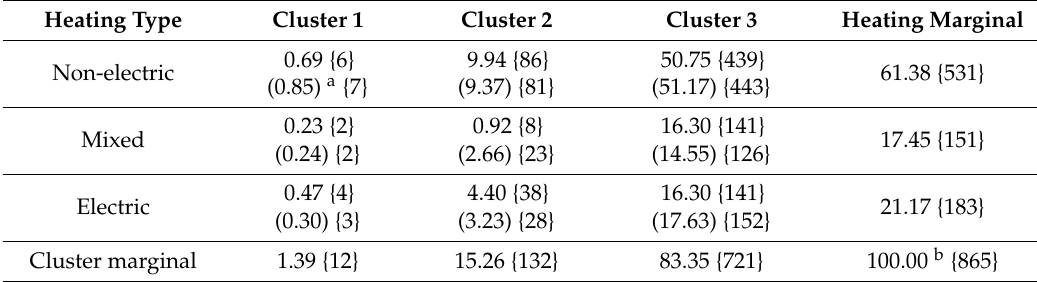
Table 6. Joint percentage distribution between heating type and